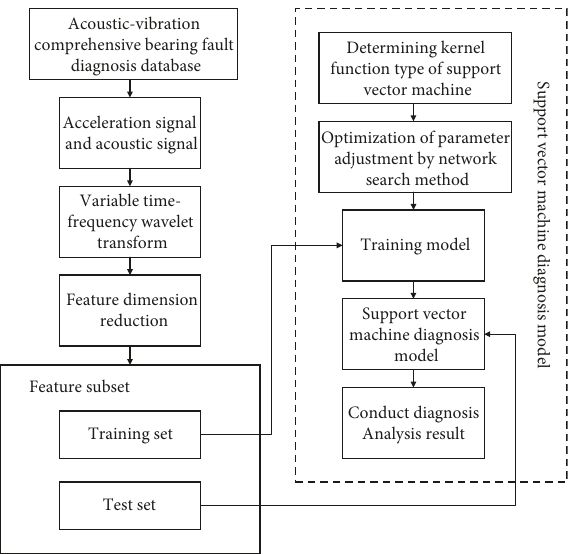
Figure 2: Flow diagram of the bearing fault diagnosis